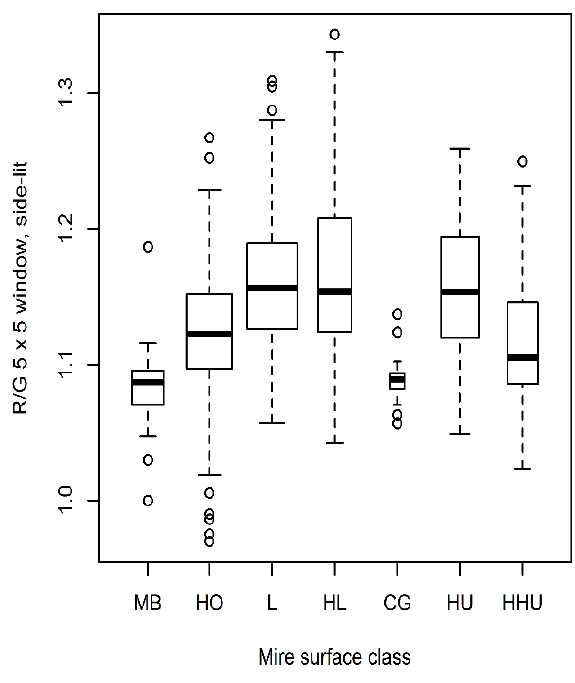
Figure 10. Boxplot diagram for the RED/GRN image feature. Observations are constrained by azimuth difference (45° >  < 135°). The width of the bars depicts the number of observations.